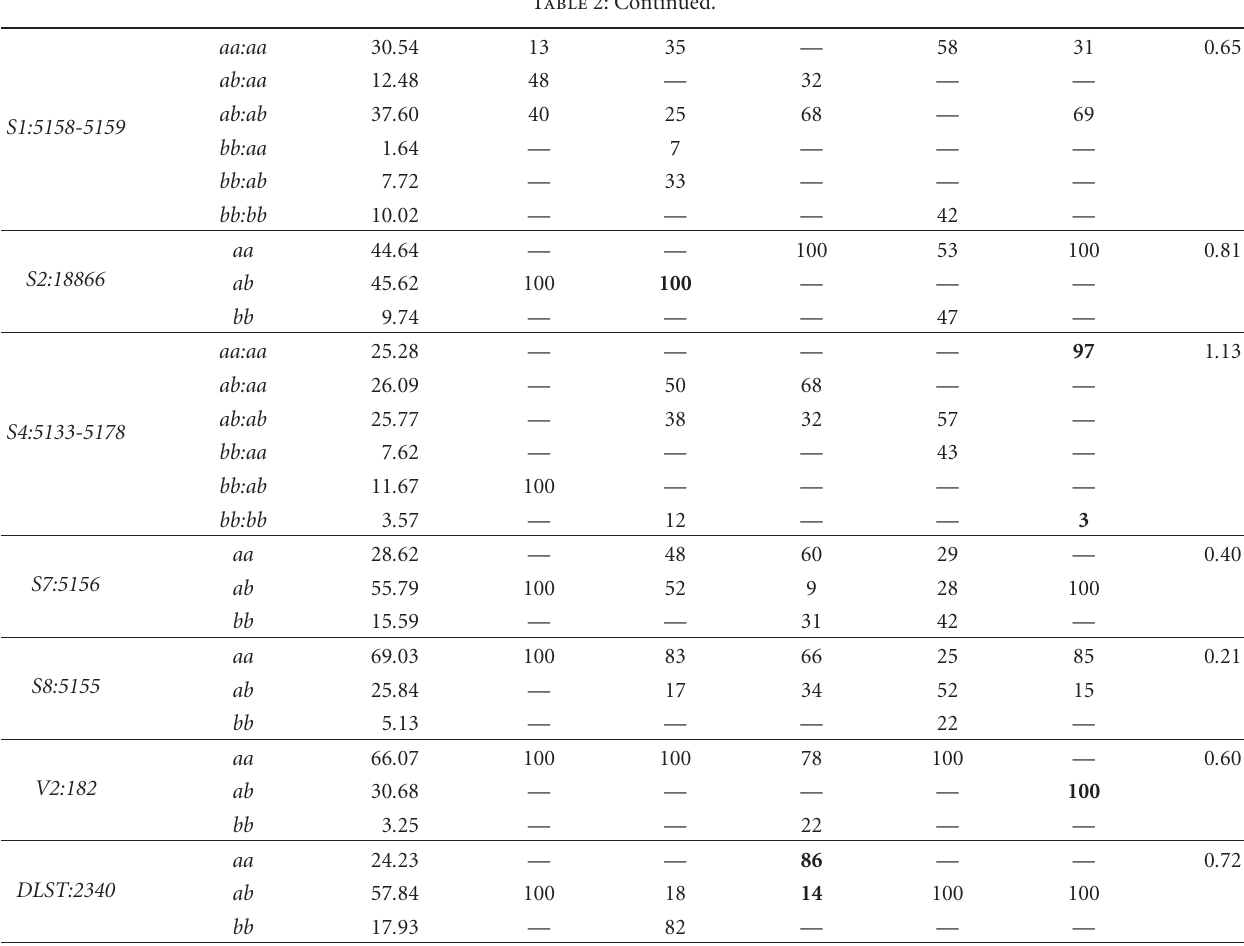
Note: influential genotypes in determining the group are indicated in bold. The question relevance factor (QRF) score for that variable and group was > 1 .